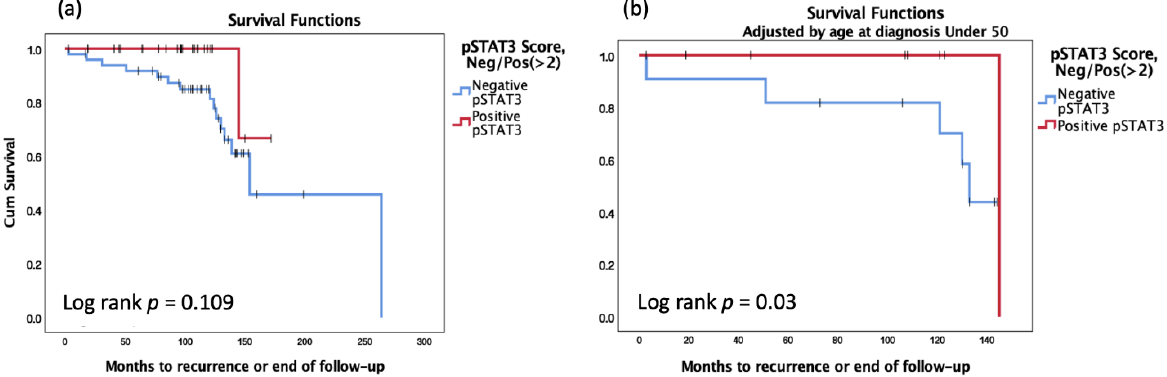
Figure 3. Kaplan – Meier analysis for DFS ( a ) according to the pSTAT3; ( b ) according to the pSTAT3 and adjusted by age Table 2. Multivariate analysis for at diagnosis.